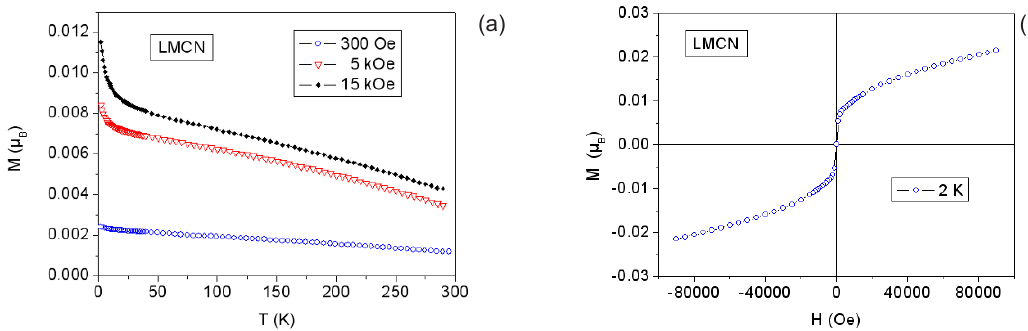
Figure 4. (a) M(T) for three applied fields and (b) M(H) versus field at 2 K of LaMg